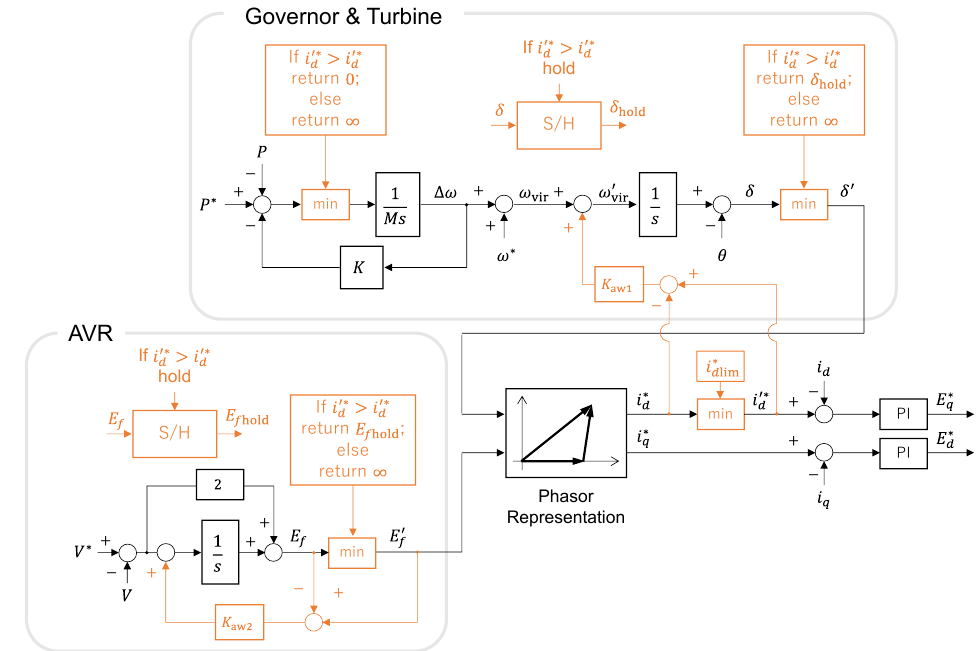
Figure 11. Block diagram of the control system with the output power limiter. The highlighted orange indicates the added mechanism to limit the current of the